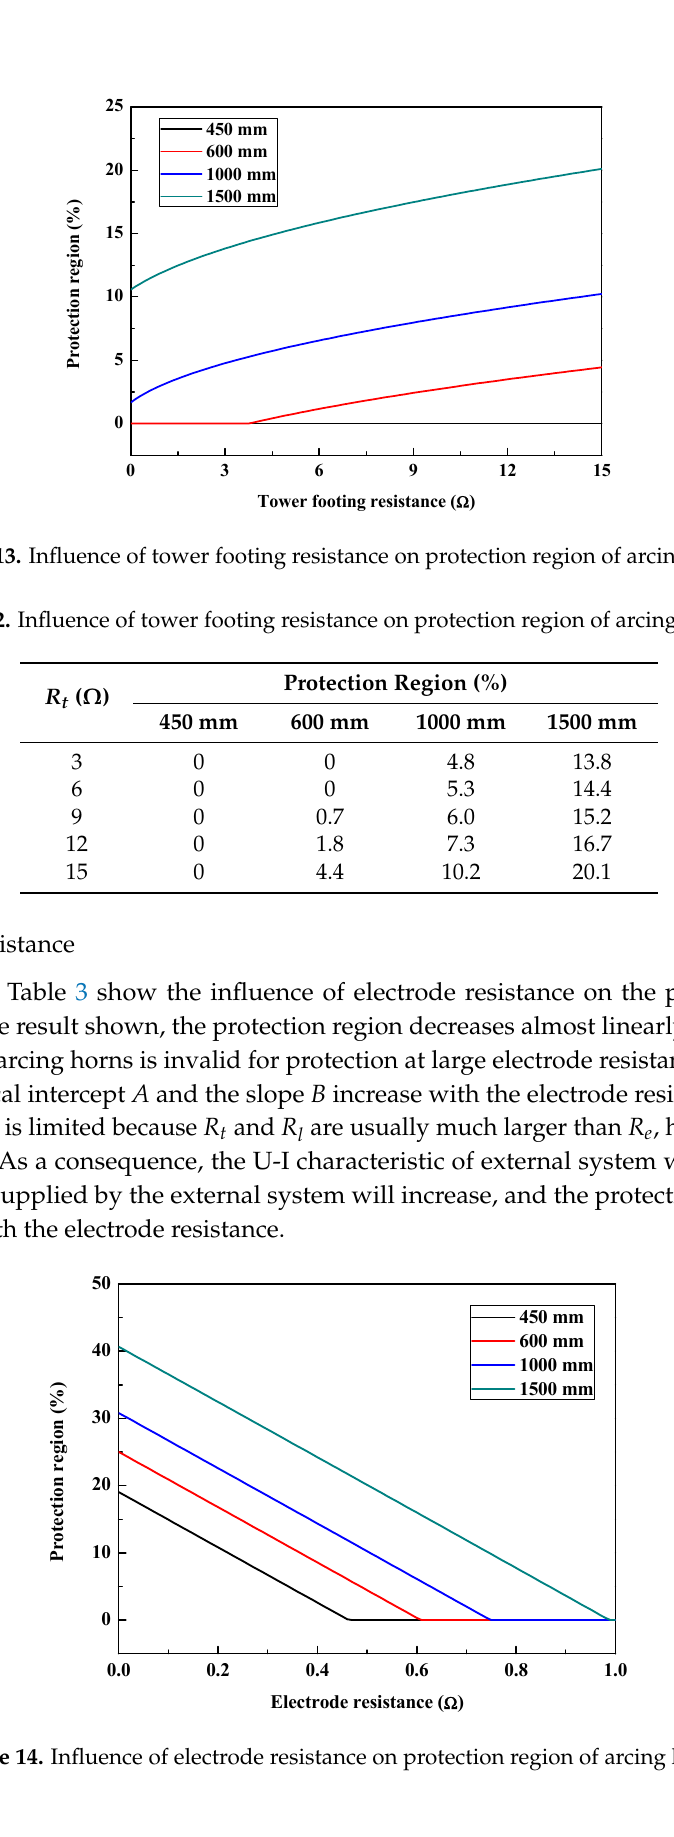
Figure 14. Influence of electrode resistance on protection region of arcing horns.